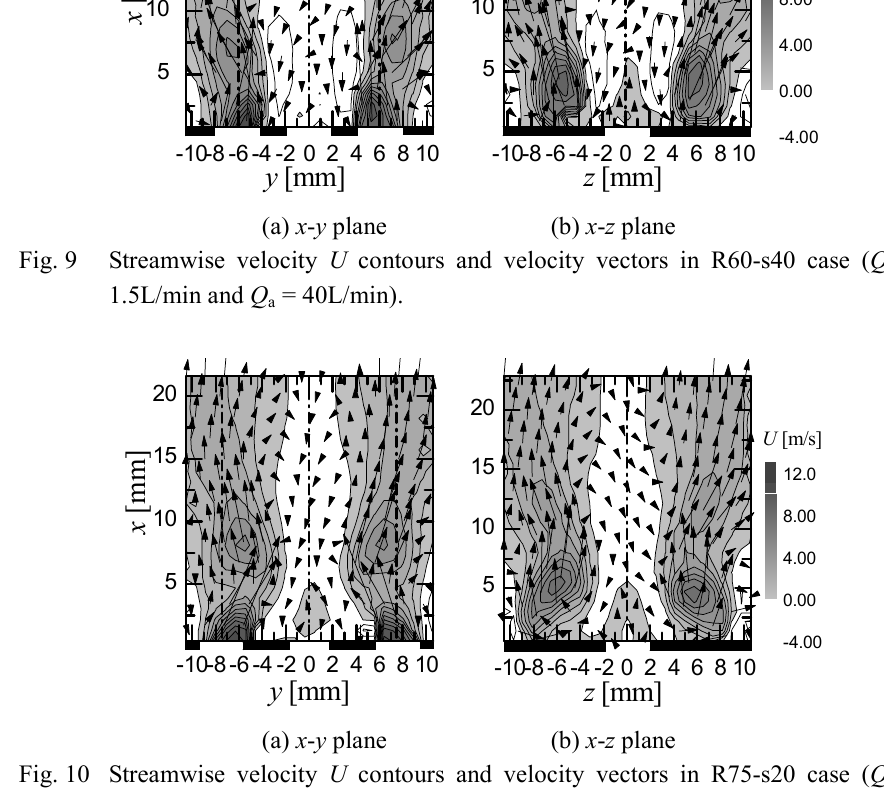
Fig. 10 Streamwise velocity U contours and velocity vectors in R75-s20 case ( Q 1.5L/min and Q = a